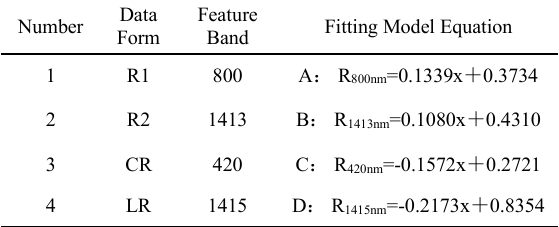
Table 4. Selection and modelling of sensitive bands for the salt content of mural samples under different spectral